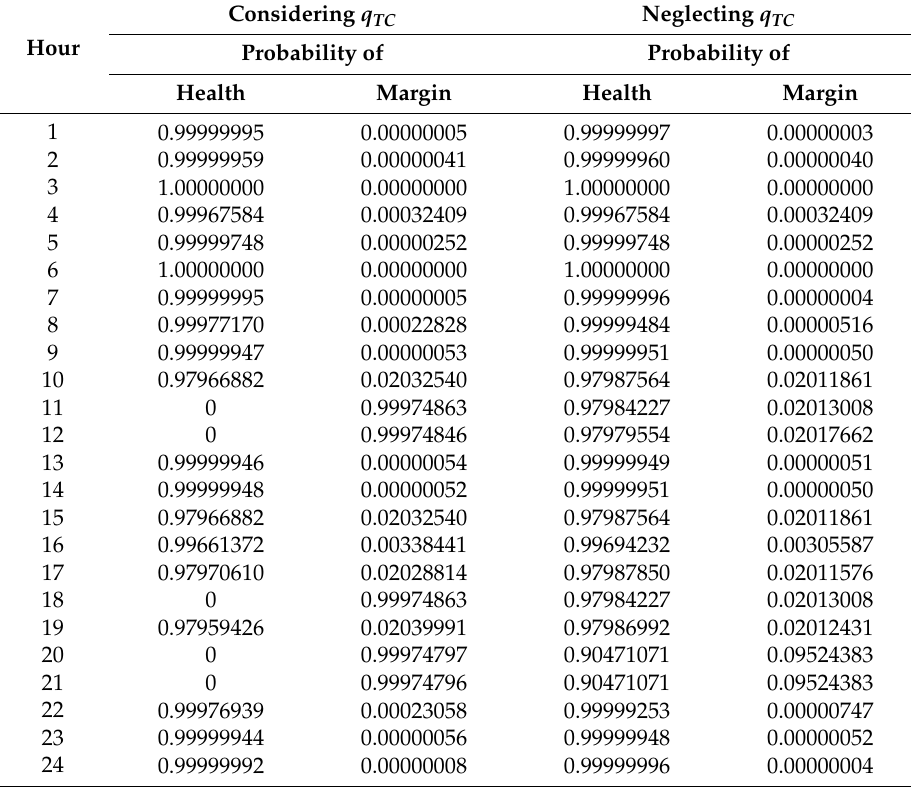
Table 6. Probabilities of health and margin under scenario